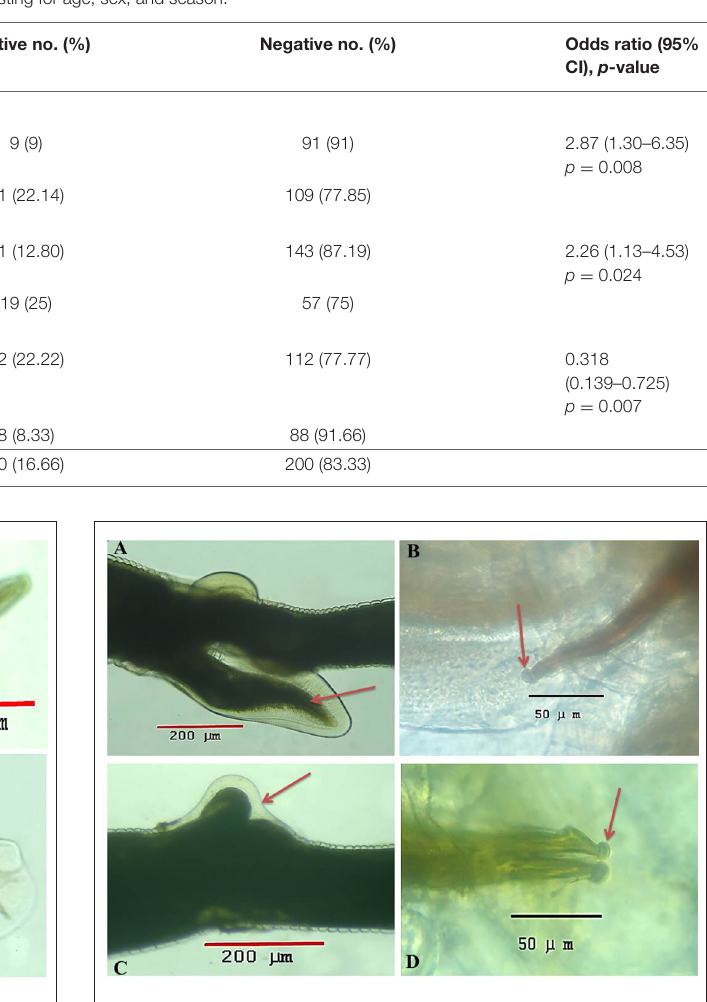
FIGURE 4 | Microscopic appearance of Haemonchus spp. isolated from the abomasum of goats using a light microscope. (A) The vulvar region of female Haemonchus contortus showing a thumb-like vulvar flap (arrow). (B) Higher magnification of the spicules of male H. contortus showing fused barbed tips (arrow). (C) The vulvar region of female Haemonchus placei showing a reduced knob-like vulvar flap (arrow). (D) Higher magnification of the spicules of male H. placei and H. longistipes showing split barbed tips